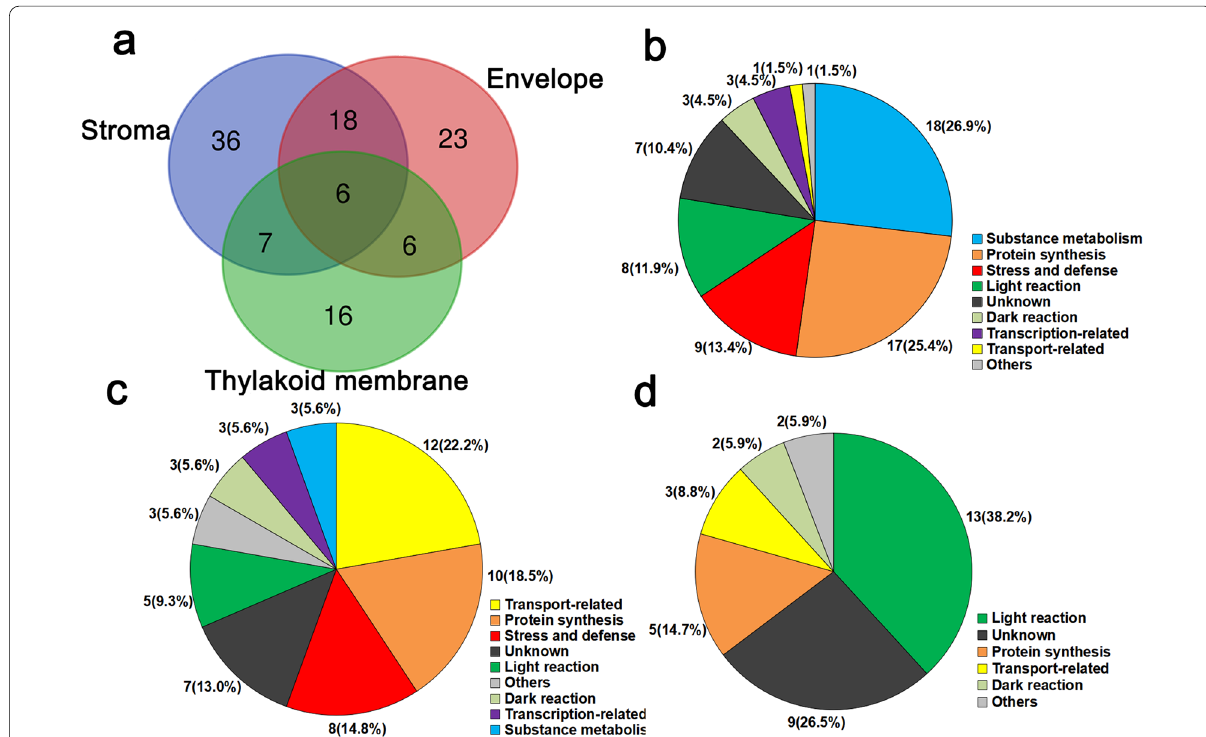
Fig. 6 Functional annotation of differential expressed proteins in different subchloroplast fractions. a Venn diagram. b Chloroplast stroma. c Chloroplast envelope. d Chloroplast thylakoid